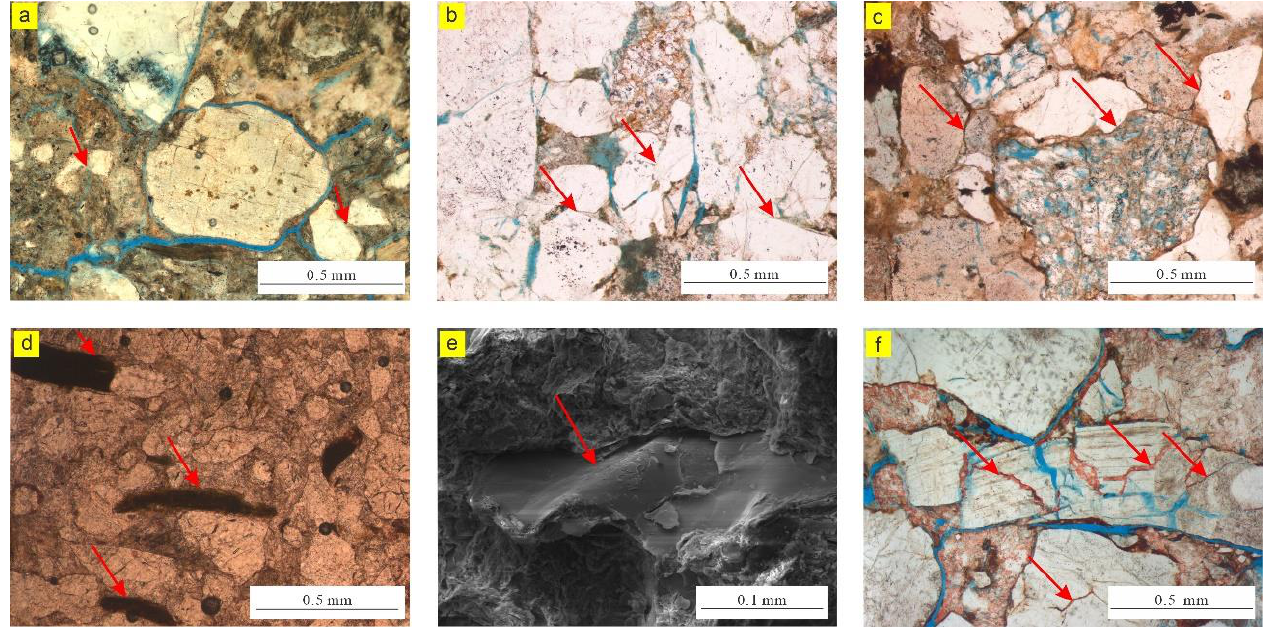
Figure 6. Characteristics of compaction in the Lower Jurassic reservoir in the Niudong area: ( a ) N1-2-22, 2146.2 m, point contact; ( b ) N102. 2112.0 m, point-line contact; ( c ) N102, 2066.5 m, line contact; ( d ) N104, 2366.1 m, directional arrangement of mica; ( e ) N102, 2067.0 m, mica extrusion deformation; ( f ) N104, 2052.4 m, fracture.